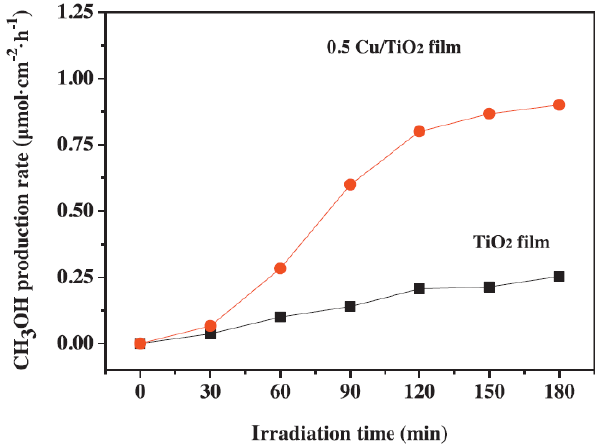
Figure 7. CH 3 OH production rate by photocatalytic reduction of CO 2 as obtained under UV light with both pure TiO 2 film and a Cu/NFF obtained by starting from 0.5 mM Cu 2+ solution (0.5 Cu/TiO 2 film).